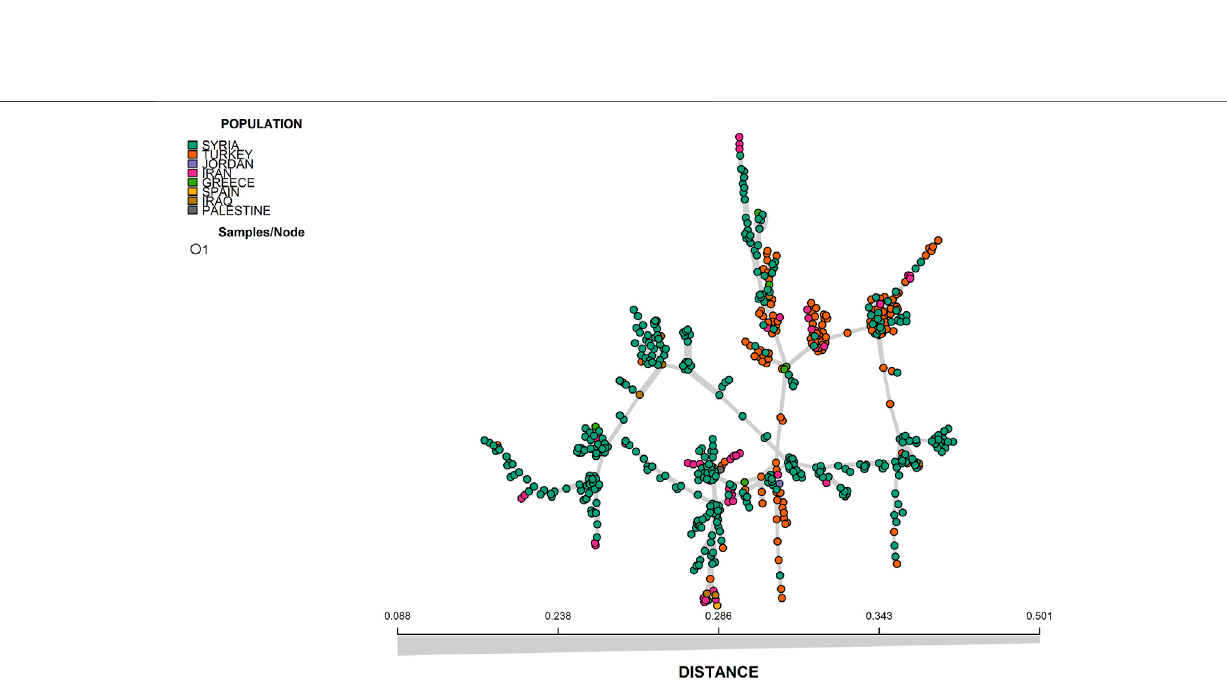
FIGURE 4 | Minimum spanning network (MSN) of 600 bread wheat